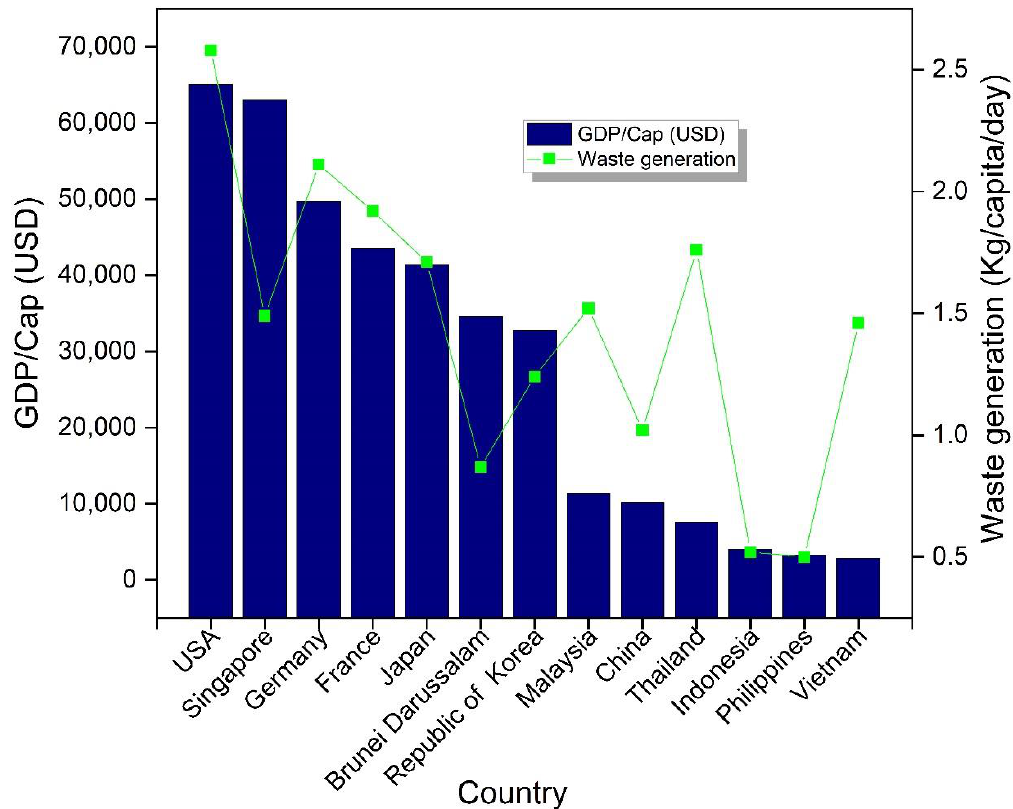
Figure 3. Relationship between GDP per capita and HSW (Household Solid Waste) generation [16,21].